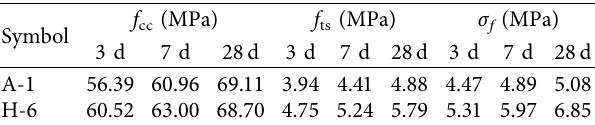
Table 6: Mechanical properties of H-6 specimen and unreinforced concrete at an early